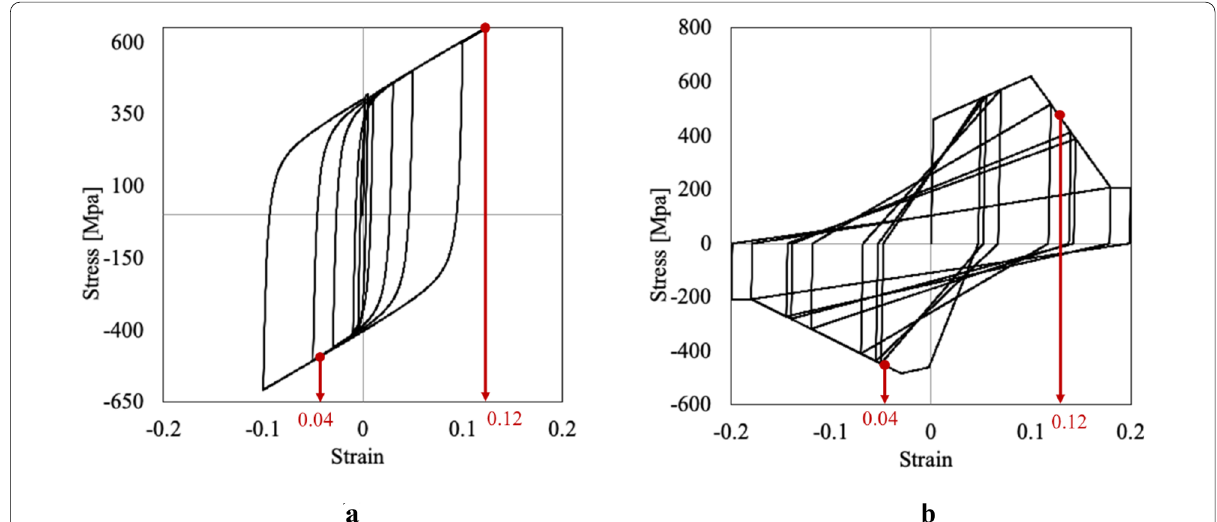
Fig. 4 Constitutive models used for reinforcing steel. a Steel02 material with and without failure constraints. b Hysteretic material with and without failure constraints.